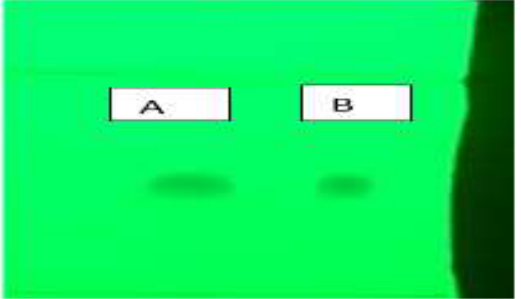
Figure 5. Analytical TLC for identification of